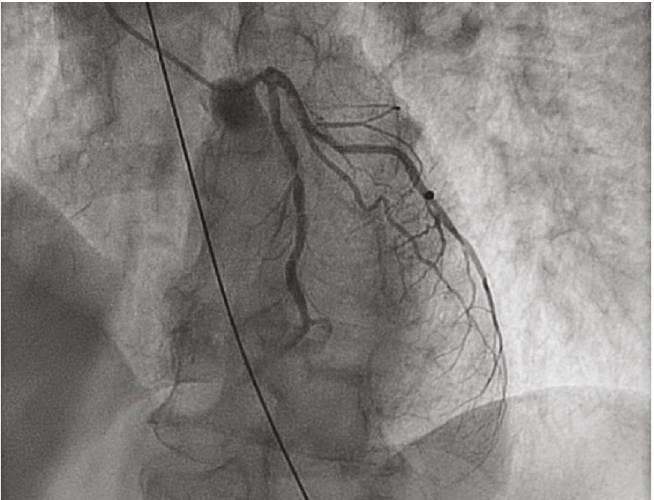
Figure 6: Coronary angiogram revealing mid-LAD stenosis.